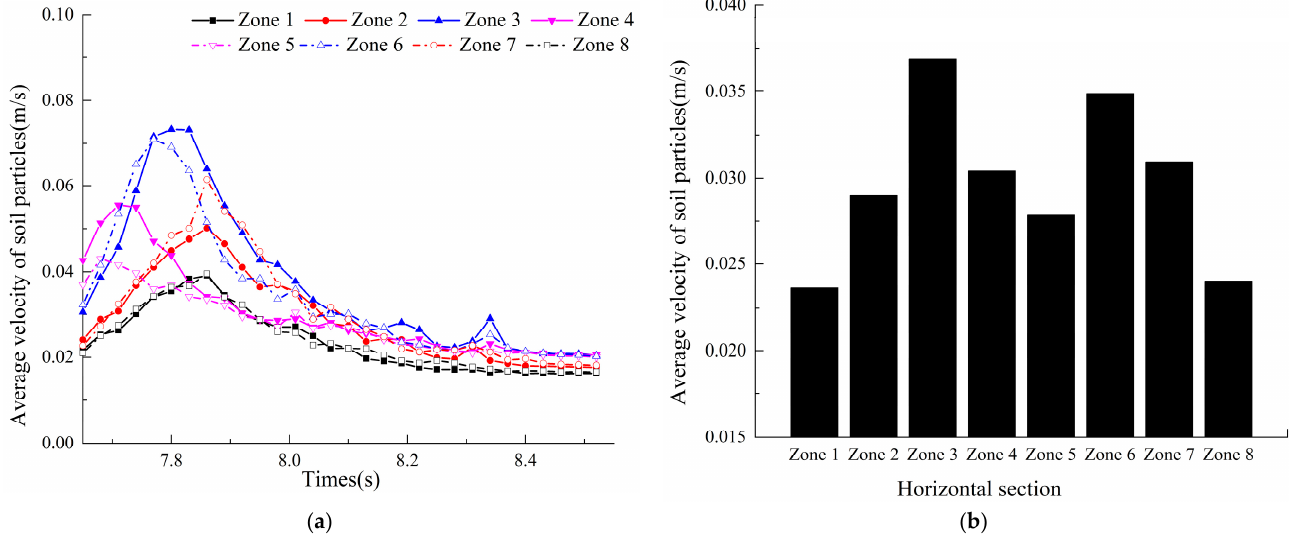
Figure 12. Variation curves of motion in different regions of the horizontal section. ( a ) Particle motion curve in the horizontal section; and ( b ) velocity variation in different